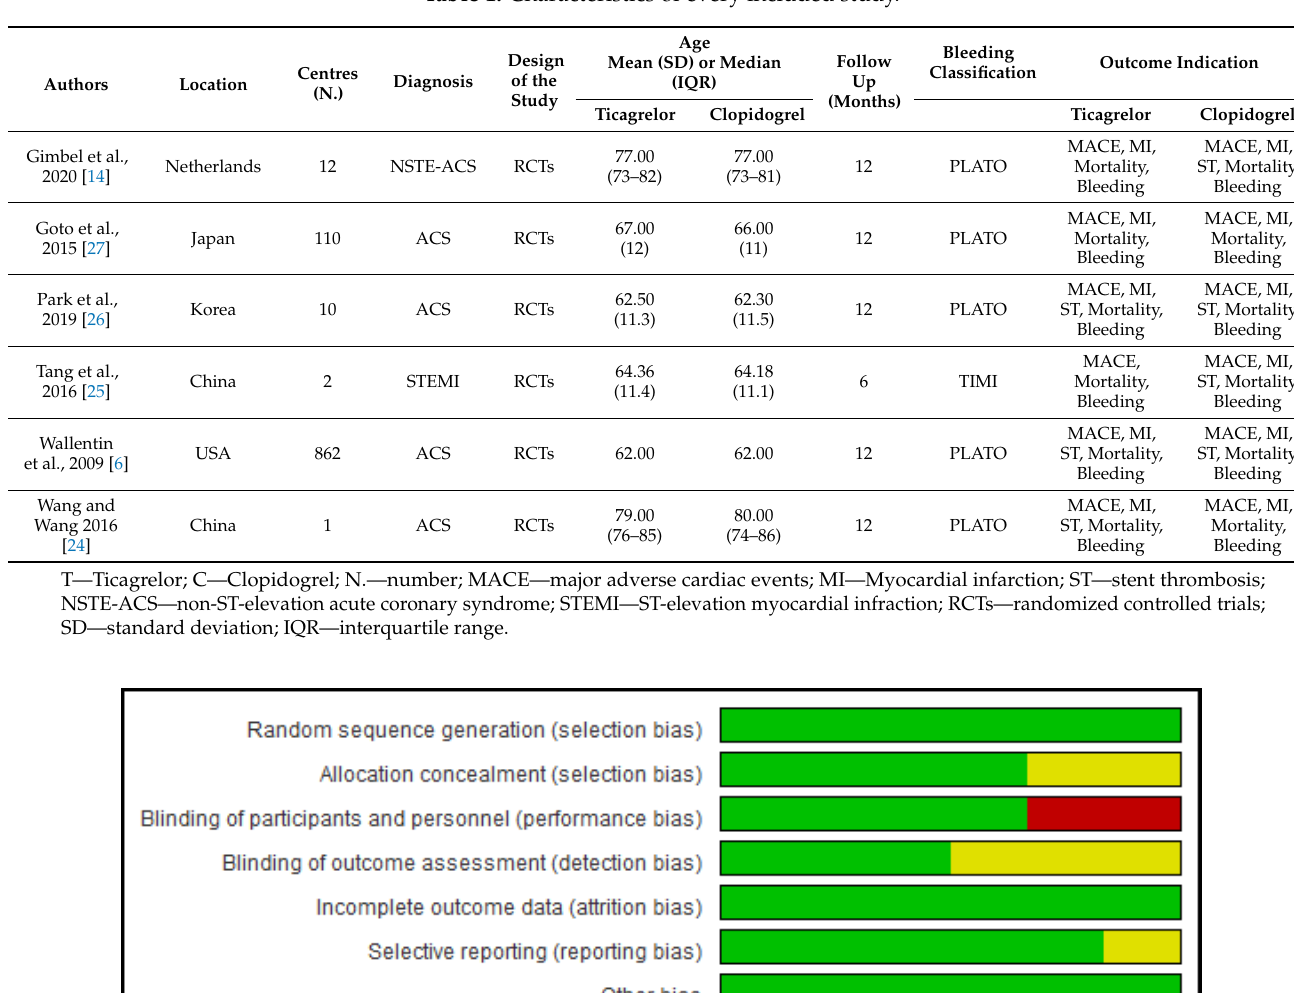
Table 1. Characteristics of every included study.